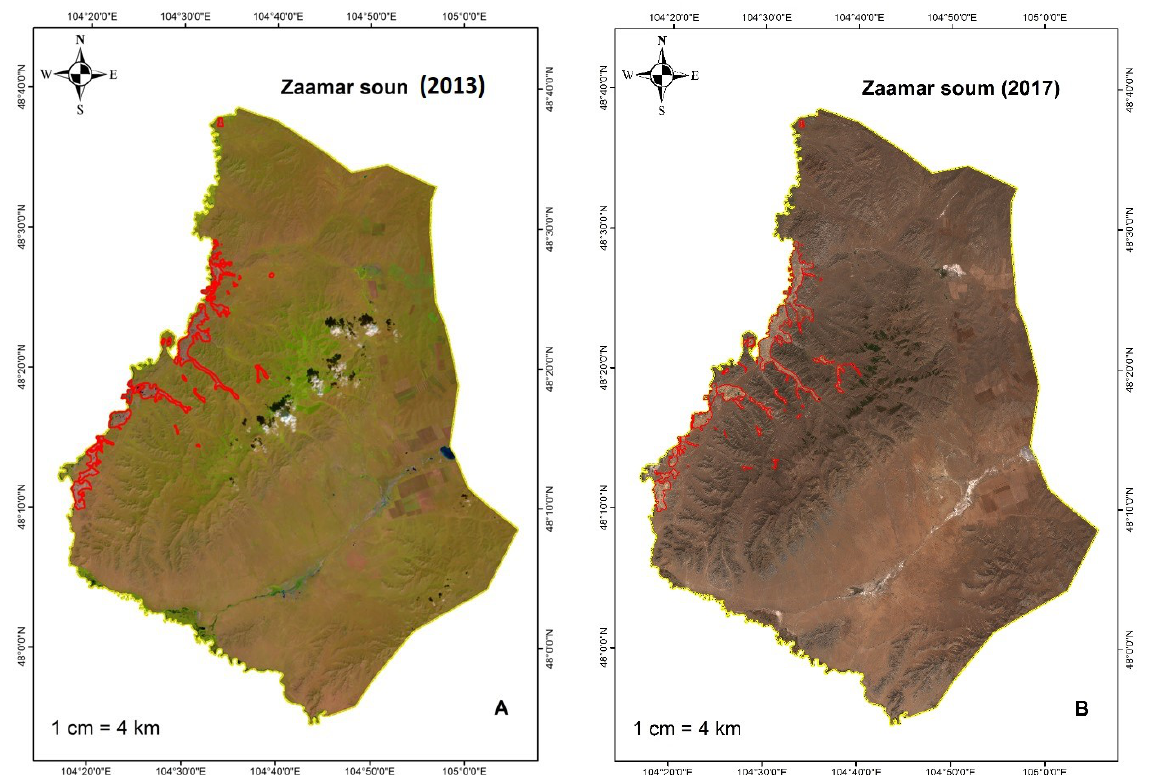
Figure 5. Landsat (A) and Sentinel (B) images of land cover in Zaamar soum in 2013 and 2017,